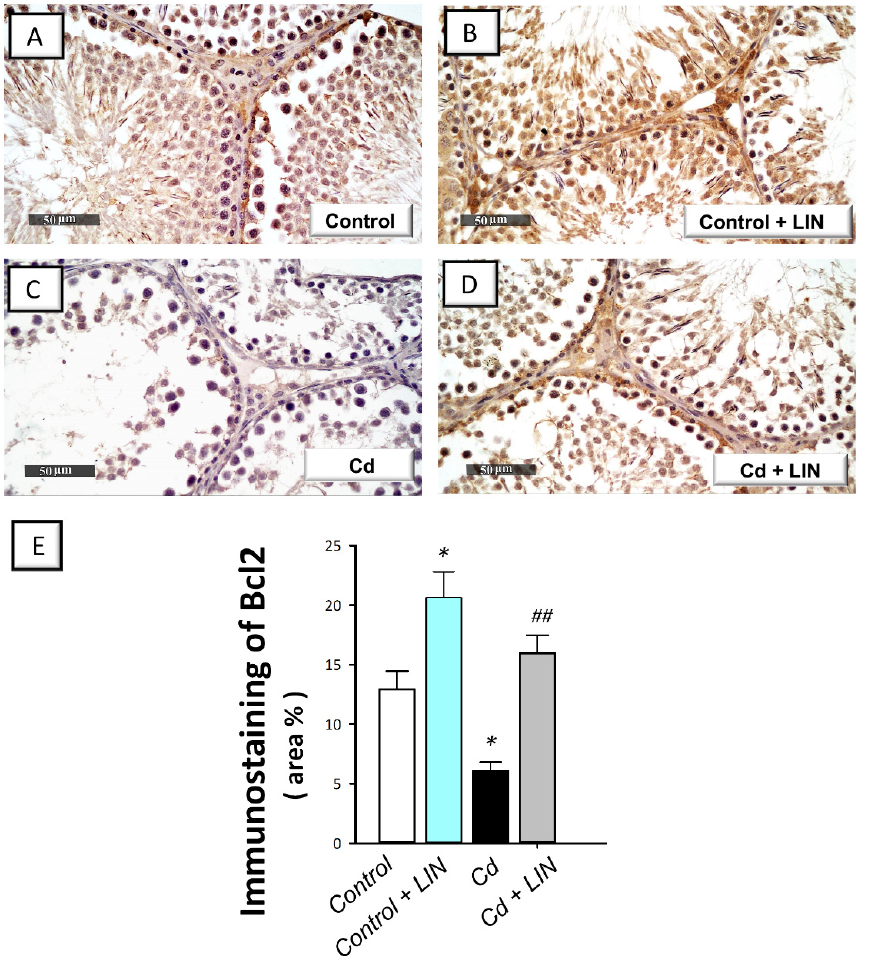
Figure 8. Effect of cadmium and/or linagliptin administration on testicular Bcl ‐ 2 protein expression in rats. The co ‐ treatment with linagliptin intensified the testicular protein expression of B ‐ cell lym ‐ sion in rats. The co-treatment with linagliptin intensified the testicular protein expression of B-cell lymphoma-2 (Bcl-2) that was downregulated by cadmium metal as detected by immunohistochem- of testicular Bcl-2 protein demonstrates intense expression in the control and control + LIN